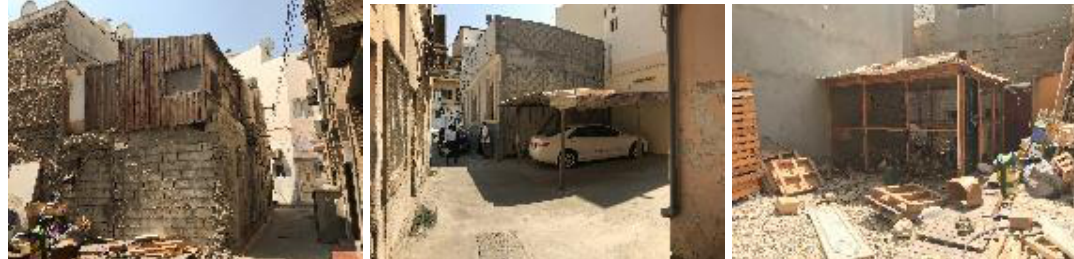
Figure 11. Miss use of vacant lands that harmful the urban